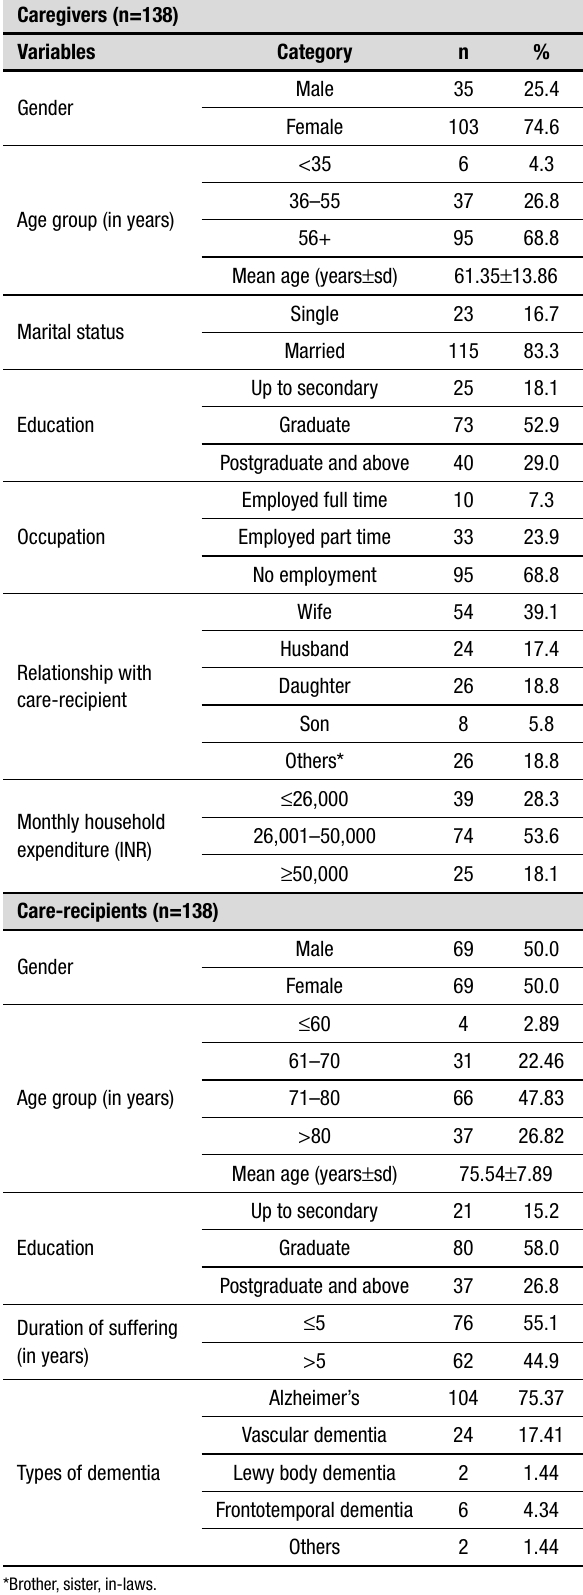
Table 1. Information of caregivers and